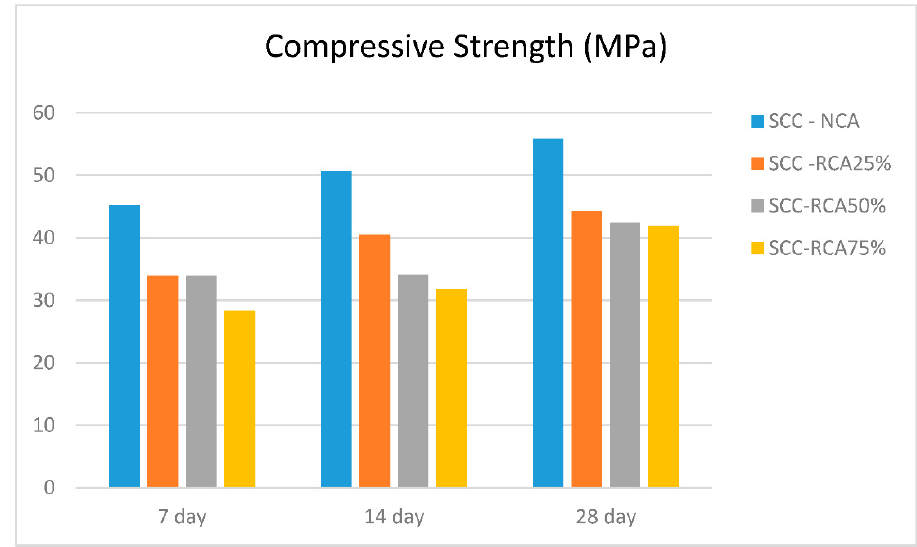
Figure 8. Compressive strength at different curing cycles.